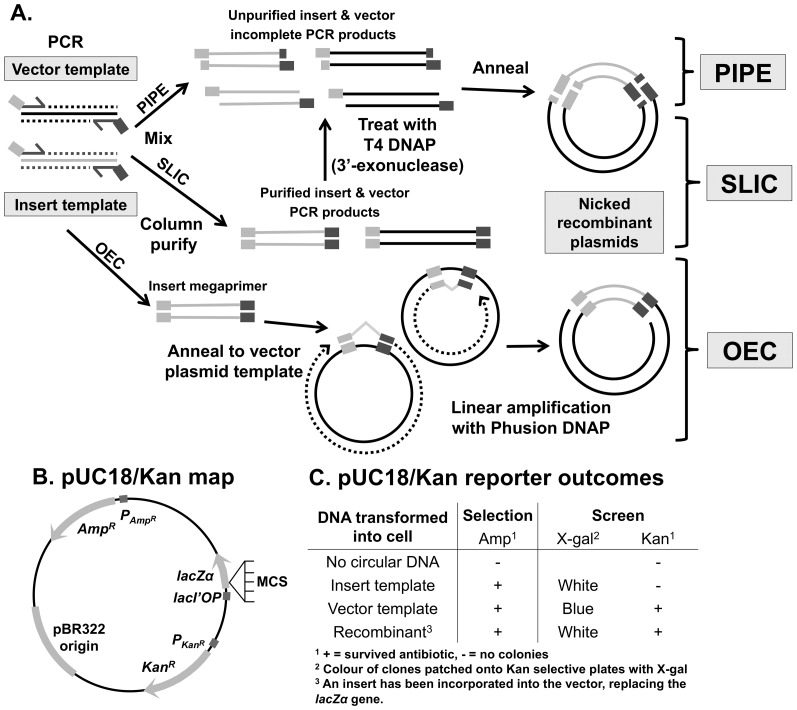
Principles of polymerase incomplete primer extension (PIPE) cloning, sequence and ligation-independent cloning (SLIC) and overlap extension cloning (OEC).(A) In PIPE, incomplete extension during PCR generates 3′-recessed ends. In SLIC, purified PCR products are treated with T4 DNA polymerase (DNAP) so that the exonuclease activity will increase the proportion of recessed ends. In both these techniques, by amplifying vector and insert with primers containing complementary 5′-tails and mixing the products, the overhangs can anneal and are joined in vivo after transformation into E. coli. In OEC, the insert PCR product acts a megaprimer to generate a nicked plasmid by overlap extension in vitro in a second round of amplification. The nicks are also repaired in vivo. For all techniques, a DpnI digestion step is included to remove plasmid template (not shown). (B) Design of the reporter vector, encoding resistance for ampicillin and kanamycin, and the alpha-fragment of beta-galactosidase. (C) Colonies from ampicillin plates were patched onto kanamycin/X-gal plates to distinguish recombinants from unwanted insert vector or empty pUC18/Kan background colonies.